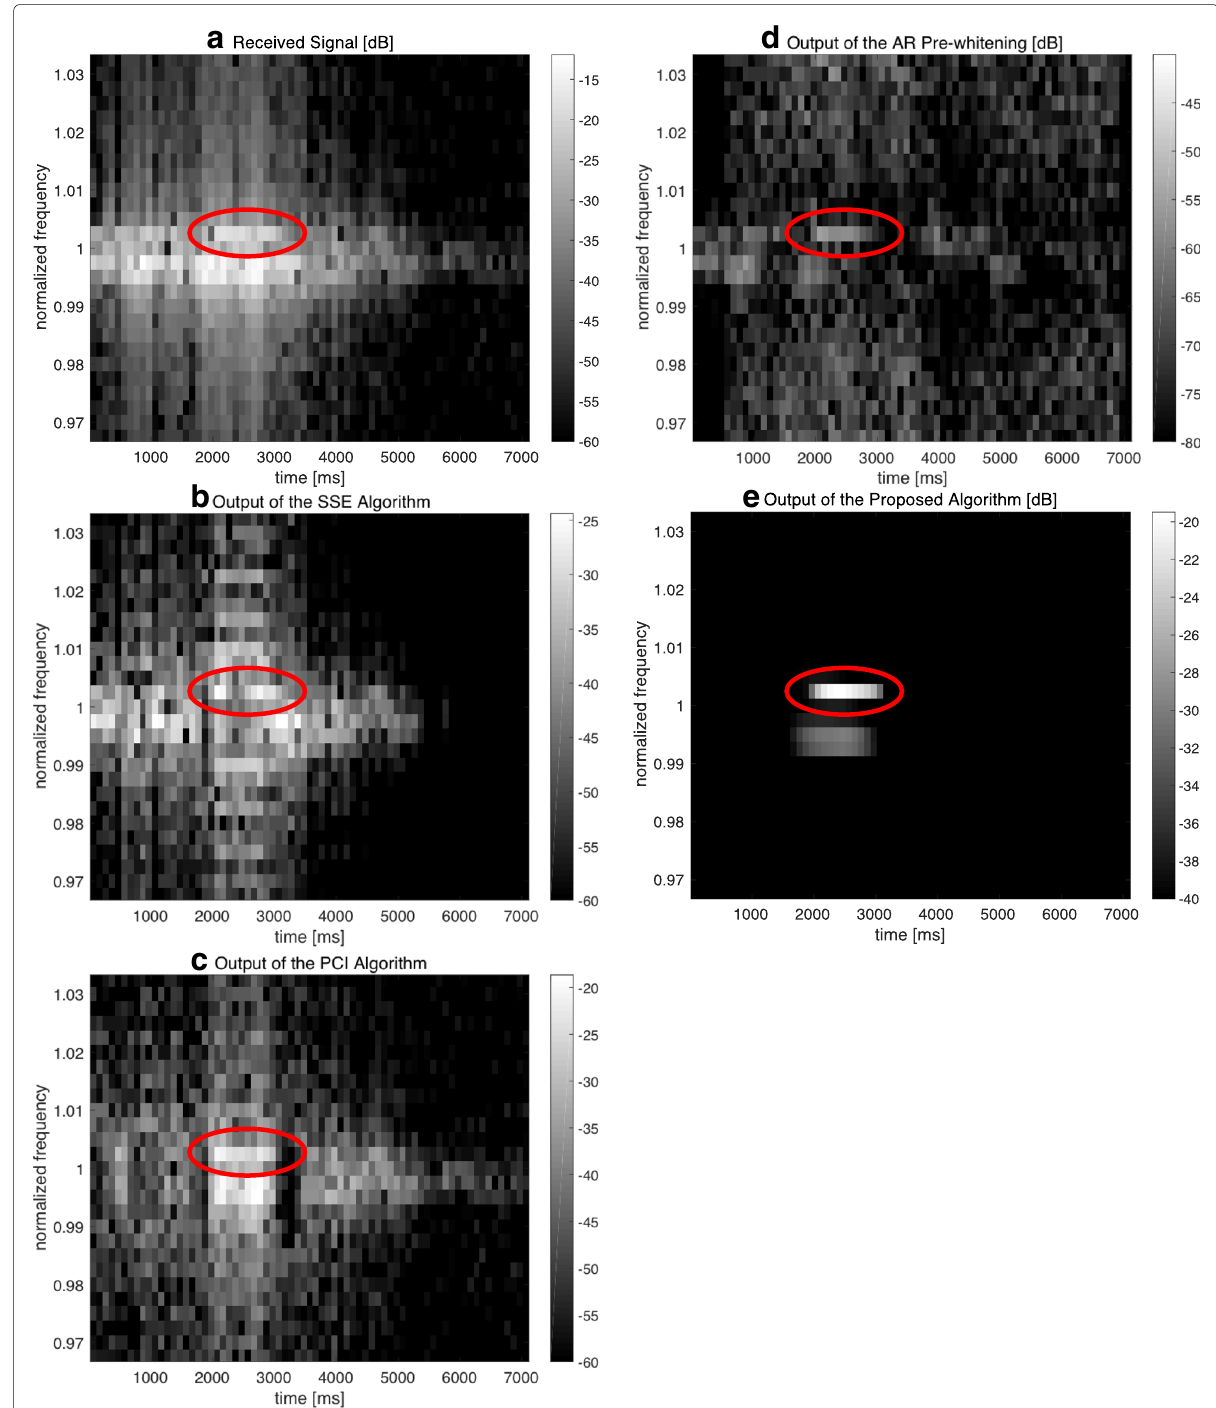
Fig. 14 Frequency analysis from measurement experiments. Spectrograms of a received signal, b output signal of the SSE algorithm, c output signal of the PCI algorithm, d output signal of the AR pre-whitening, and e output signal of the proposed algorithm. Red circle indicates the target echo